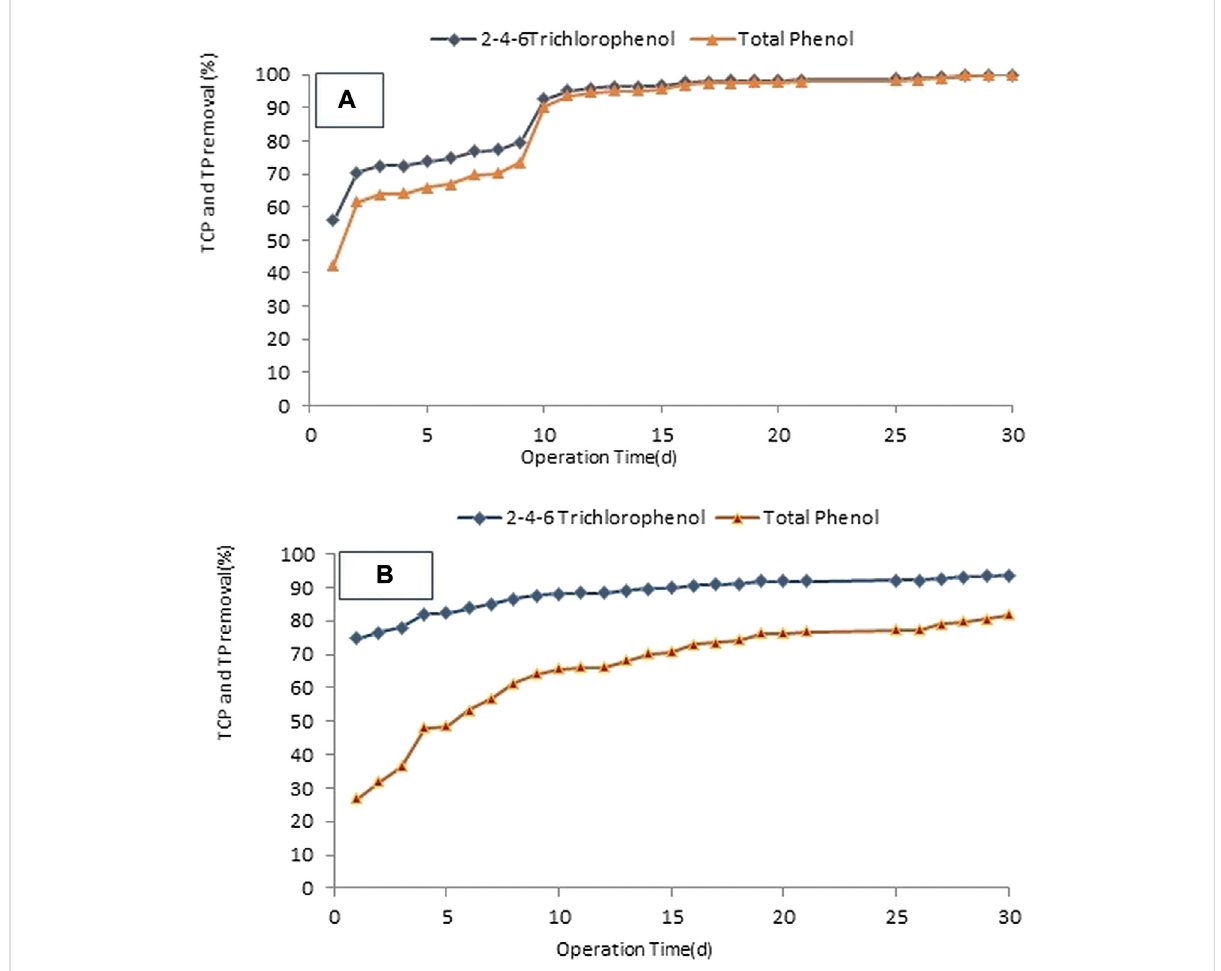
FIGURE 2 TCP and TP removal during the Acclimation phase. (A,B) . Biomass acclimation in separate anaerobic and aerobic